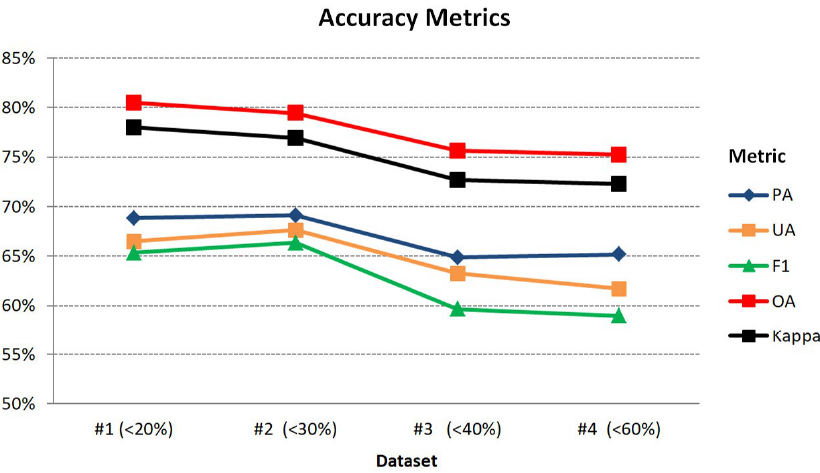
Figure 6. Accuracy metrics for the SVM experiments on the four different cloud cover datasets.